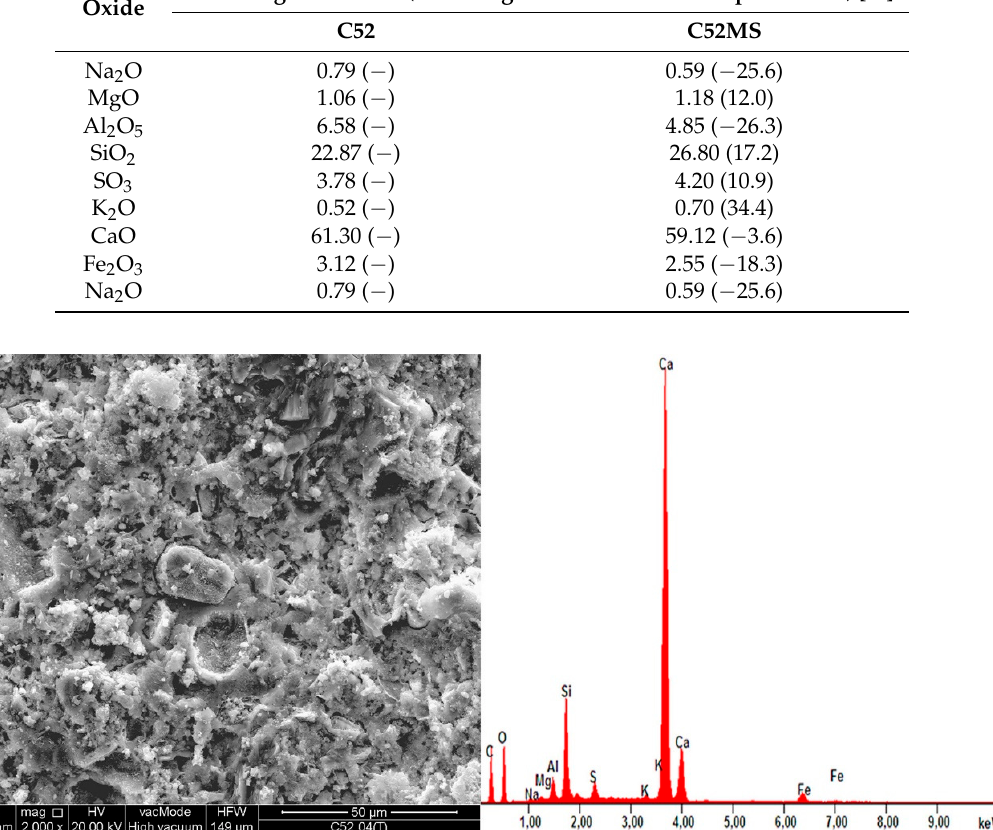
Figure 11. EDS spectra of the C52MS sample together with the SEM image of the area analyzed. 4. Conclusions The paper presents the results of the investigations of cracking patterns of modified cement pastes exposed to elevated temperatures. On the basis of the reviewed literature, and then analyzed and interpreted research results, the following conclusions were drawn: (1) Computer image analysis tools could be successfully applied to the quantitative description of cracking patterns. (2) While analyzing the structure of the cement paste as a dispersion system, factors influencing the process of self-assembly of cluster structures were identified at the initial binding stage. Geometric characteristics of the clusters depended on the technological variables in a production process of the cement pastes. The process of a structure self-assembly was shaped by intermolecular interactions in a dispersion medium of the cement paste, and on physico- chemical changes in the system occurring as a result of the cement hydration. (3) The cluster size was mainly shaped by capillary forces, which increased with the size of cement grains; the larger the size of the cement grains, the larger the size of the clusters. (4) With a decrease in the amount of binder in the material’s volume (increase in w / b ), the size of clusters and cracks width increased.